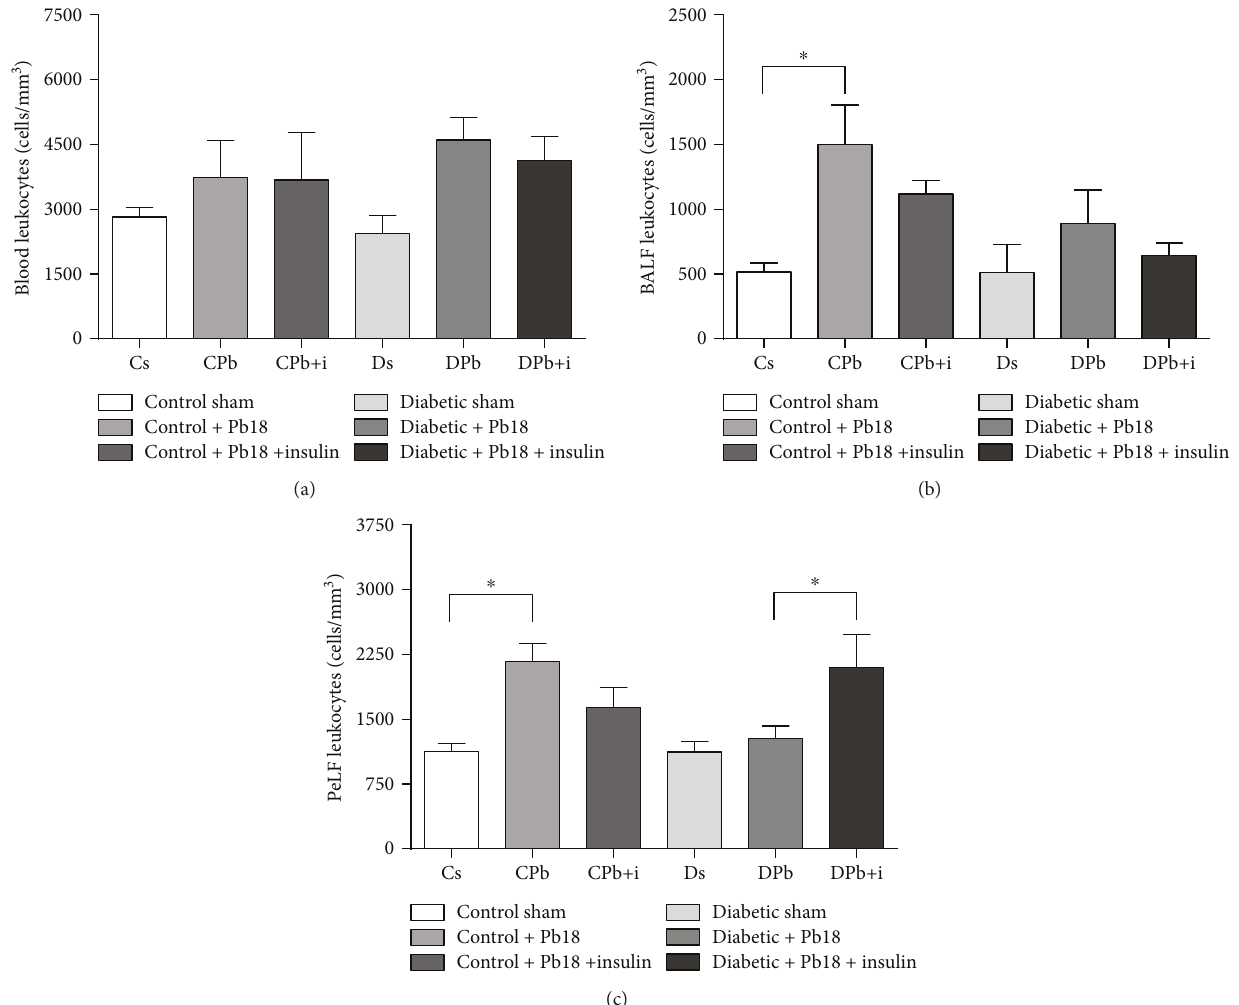
Figure 3: Blood/lavage fl uid cellular analysis. Mice were rendered diabetic via injection of alloxan (60 mg/kg i.v.) and infected with P. brasiliensis (1 × 10 6 cells i.t.). Samples were obtained 55 days after alloxan injection and 45 days after the incubation period. Five animals were included in each group. Values are the means ± SEM. (a) Leukocyte count in total blood. (b) Leukocyte count in BALF. (c) Leukocyte count in PeLF. ∗ p < 0 05 ; ∗∗ p < 0 01 ; ∗∗∗ p < 0 001 Figure 4(a)), TCD8+ cells (CD3+/CD8+; Figure 4(b)), B lym- phocytes (CD19+; Figure 4(c)), NK cells (NK1.1+/CD3 − ;